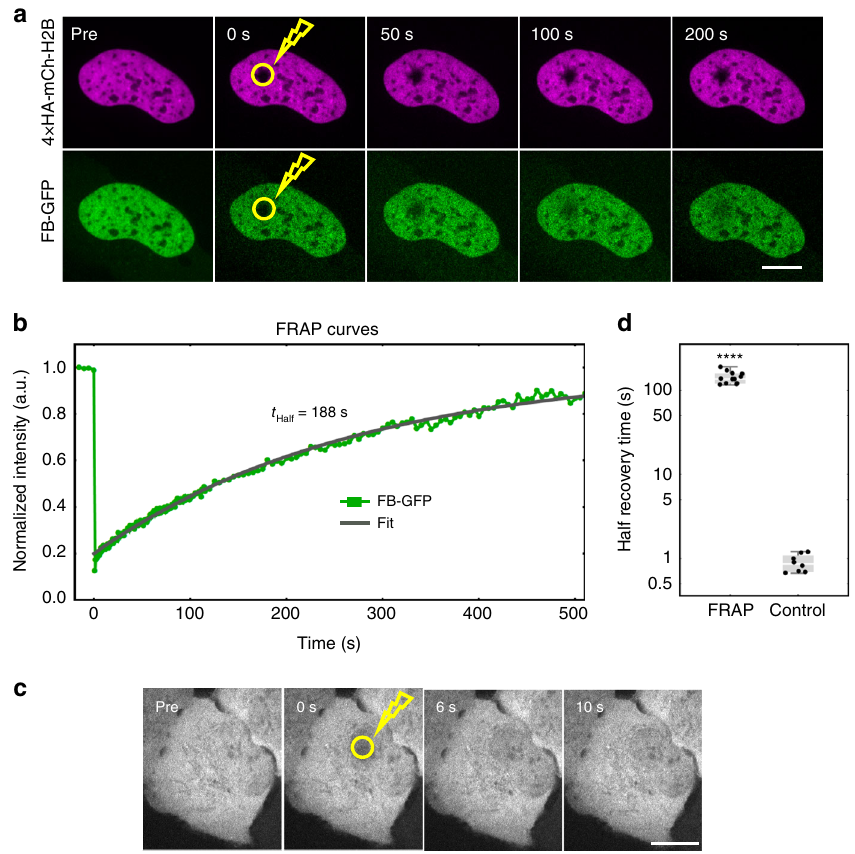
Fig. 4 HA frankenbody binds the HA epitope for minutes in cells. a A representative FRAP experiment (yellow circle indicates bleach spot) showing fl uorescence recovery in cells expressing frankenbody (FB-GFP; green) and target 4 × HA-mCh-H2B (magenta). b Quanti fi cation of FRAP data in a representative cell, along with a fi tted curve. c A representative FRAP experiment (yellow circle indicates bleach spot) in cells expressing FB-GFP only (i.e. cells lacking HA-tags) is complete in less than 10 s. d Half recovery time plot of FRAP experiments (FB-GFP and 4 × HA-mCh-H2B, n = 12 cells in 2 independent experiments, as in b ) and controls (FB-GFP only, n = 8 cells in one independent experiment, as in c ). Fits from 12 cells reveal the FRAP mean half recovery time, t half , is 141 ± 7 s (cell-to-cell SEM). Student ’ s t -test. **** p < 0.0001. Scale bars, 10 µ m. Source data are provided as a Source Data fi le. For the box and whisker plots, median is shown by a white line, the box indicates 25 – 75% range, and whiskers indicate 5 – 95%